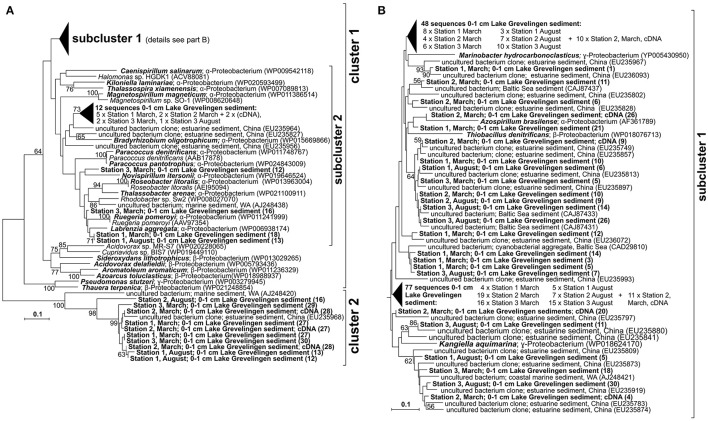
(A) Phylogenetic tree of partial nirS gene sequences of denitrifying bacteria retrieved in this study, (B) detail of subcluster 1 as indicated in (A). 147 DNA sequences recovered from stations S1, S2, and S3 between 0 and 1 cm sediment depth, in March and August by amplification (PCR) and cloning and 28 cDNA sequences obtained from station S2 between 0 and 1 cm sediment depth in March recovered by amplification (qPCR) and cloning) and closest relatives (bold: our sequences and closest known relatives); the scale bar indicates 25% sequence divergence.